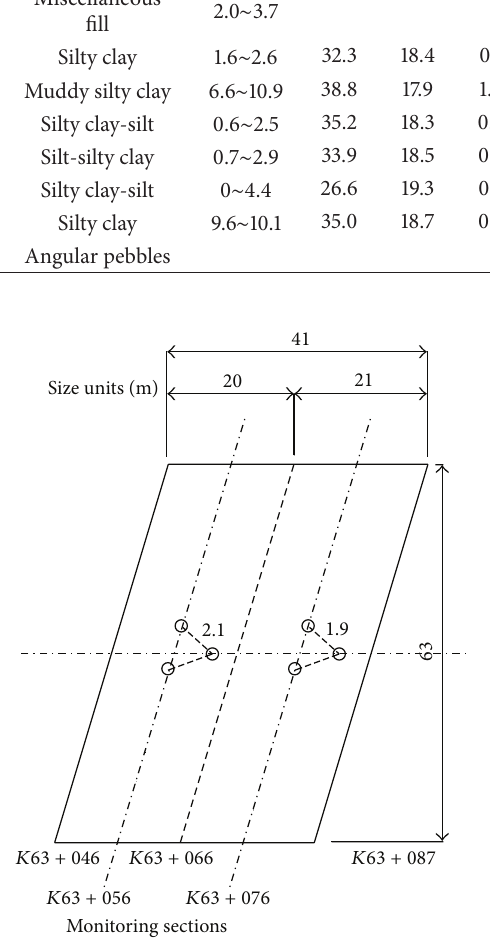
Figure 12: Test section layout